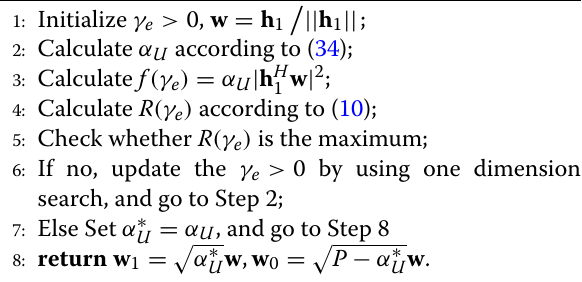
Algorithm 3 The MRT-based suboptimal